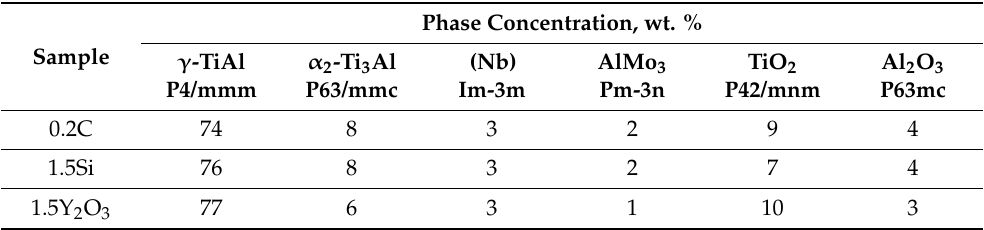
Figure 5. The XRD patterns of the 0.2C, 1.5Si, and 1.5Y 2 O 3 alloys ’ oxidized layers after annealing at 800 °C. Table 3. The phase composition of the 0.2C, 1.5Si, and 1.5Y 2 O 3 alloys after oxidation annealing at 800 °C.